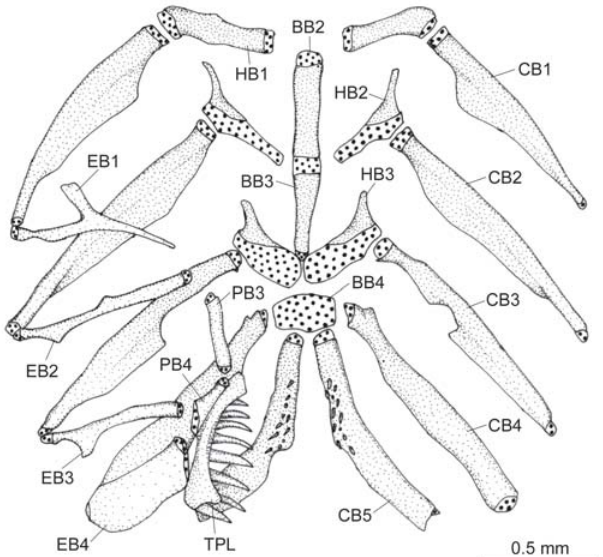
Fig. 6. Branchial skeleton of Ituglanis macunaima , paratype, MZUSP 86251 (25.5 mm SL), dorsal view, right dorsal ele- ments and gill rakers not shown. Abbreviations: BB2-4,